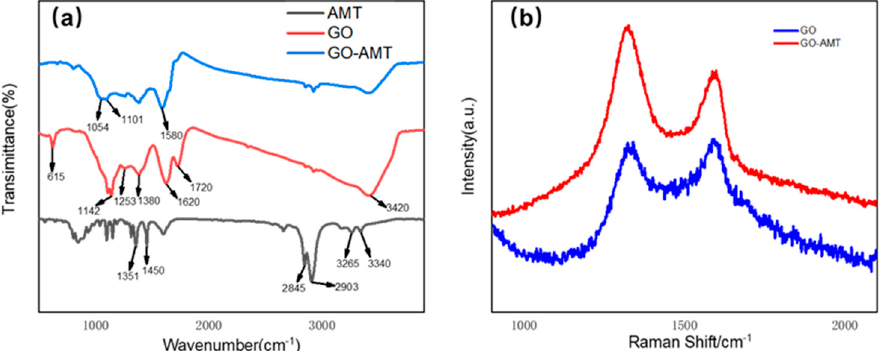
Figure 3. Spectral characterizations of GO and GO-AMT: ( a ) Fourier transform infrared spectroscopy (FTIR) and ( b ) Raman Spectra.